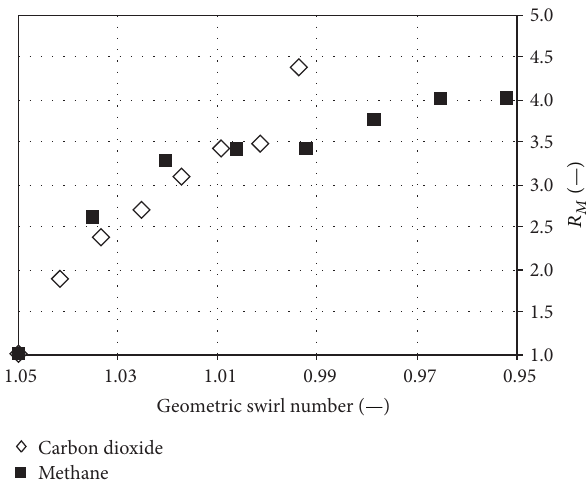
Figure 13: Normalised effect of the injection of carbon dioxide and methane on the ratio between RFM and